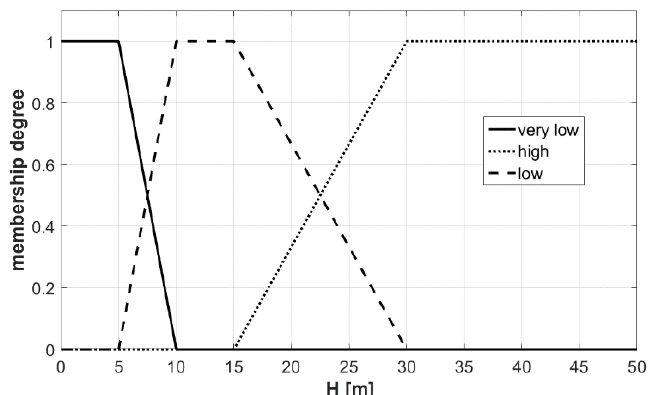
Figure 10. Membership degree of the input variable of height above the runway H associated with fuzzy sets: very low, low, high.